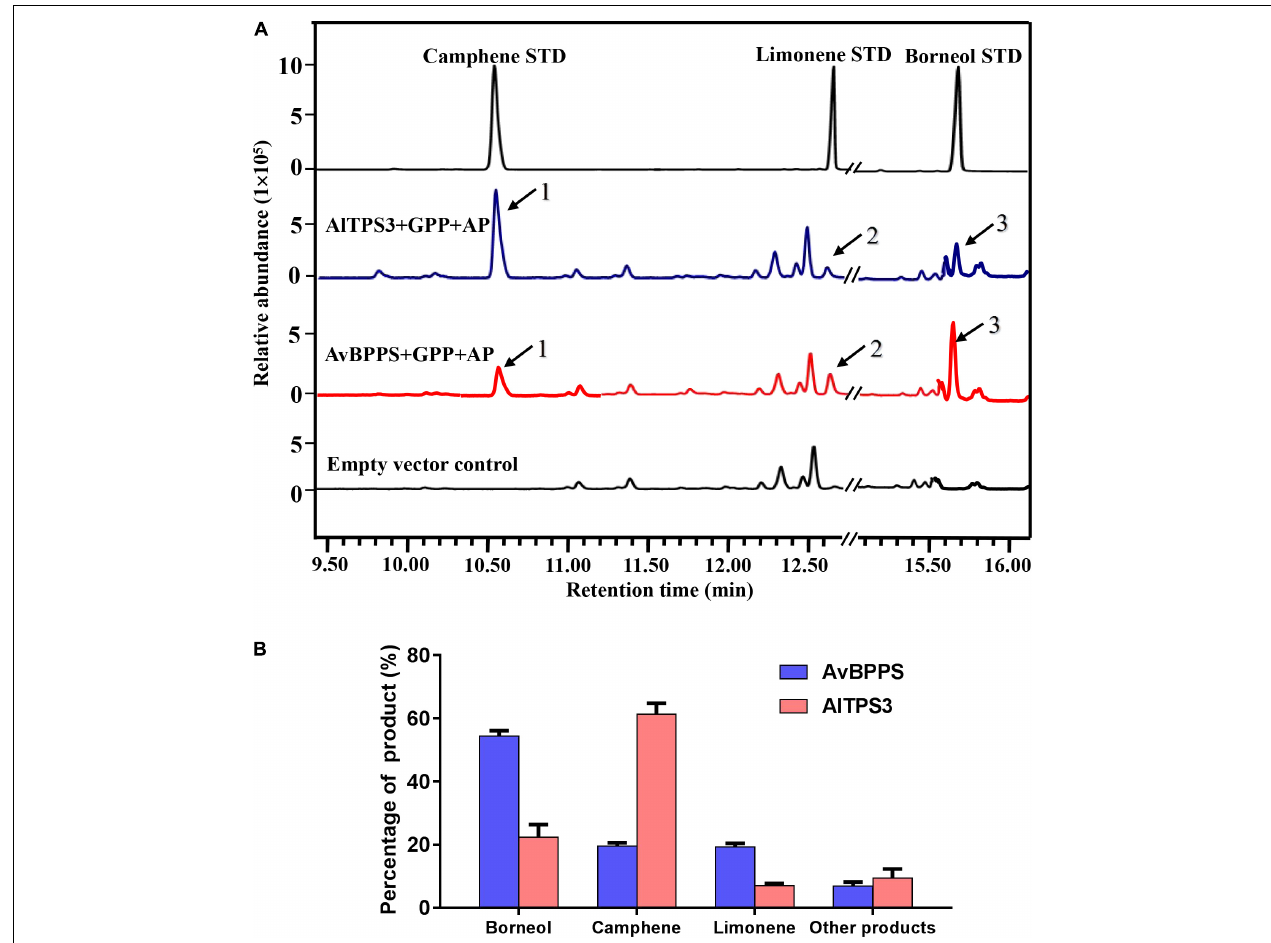
FIGURE 5 | Analysis of reaction products generated by recombinant protein AlTPS3 and AvBPPS from GPP. (A) The GC-MS chromatogram of the monoterpenoid products generated by AlTPS3 and AvBPPS protein and the camphene, limonene and borneol mixed standards. Mass spectra of peak 1, peak 2 and peak 3 in the NIST17 library compared with mass spectra of the camphene, limonene and borneol standards shown in Supplementary Figure 6 . (B) Product percentage of AvBPPS and